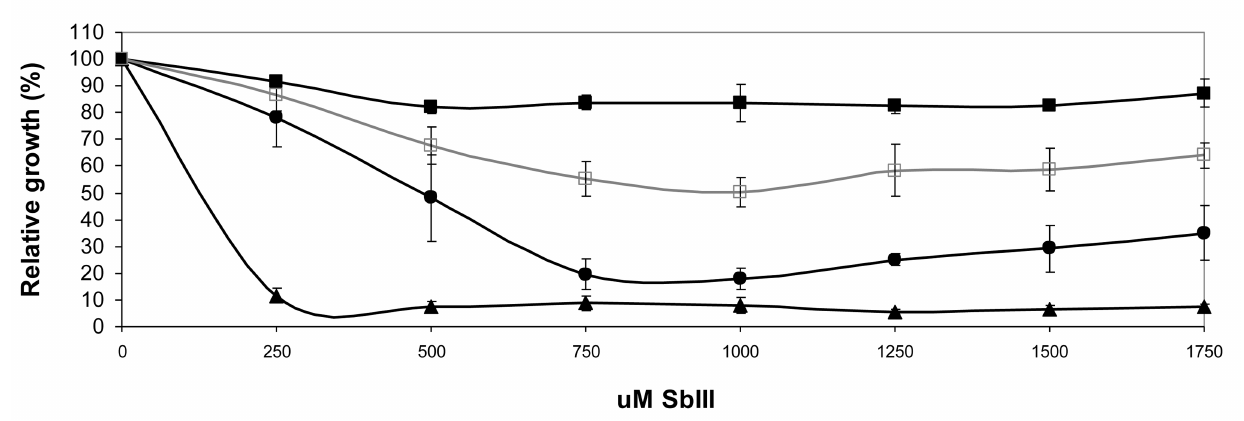
Figure 2. Antimony susceptibilities in Sb2000.1 and Sb2000.1REV transfected with LinJ.33.1810-WT. Growth curves in the presence of increasing drug concentrations were performed by monitoring 72-hour cultures by OD measurement at 600 nm. The average of at least three independent experiments is shown. L.infantum WT (filled triangles); Sb2000.1 transfected with pSP72- αNEOα (filled squares); Sb2000.1 transfected with pSP72-αNEOα-LinJ.33.1810WT (open squares); Sb2000.1REV (filled circles). doi: